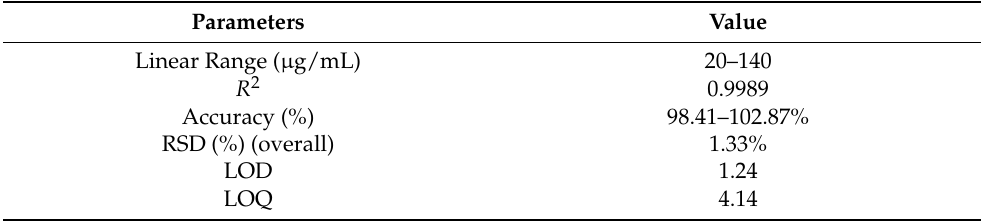
Table 4. Results of validation parameters .